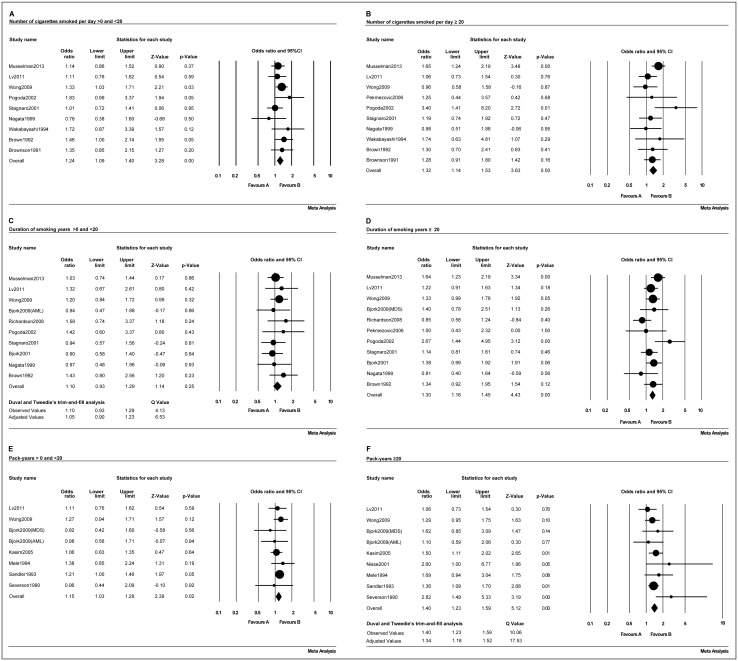
Forest plots of the association of adult myeloid disease with the smoking status based on cigarettes smoked per day (A-B), the duration of smoking (in years) (C-D), and the pack-years smoked (E-F).